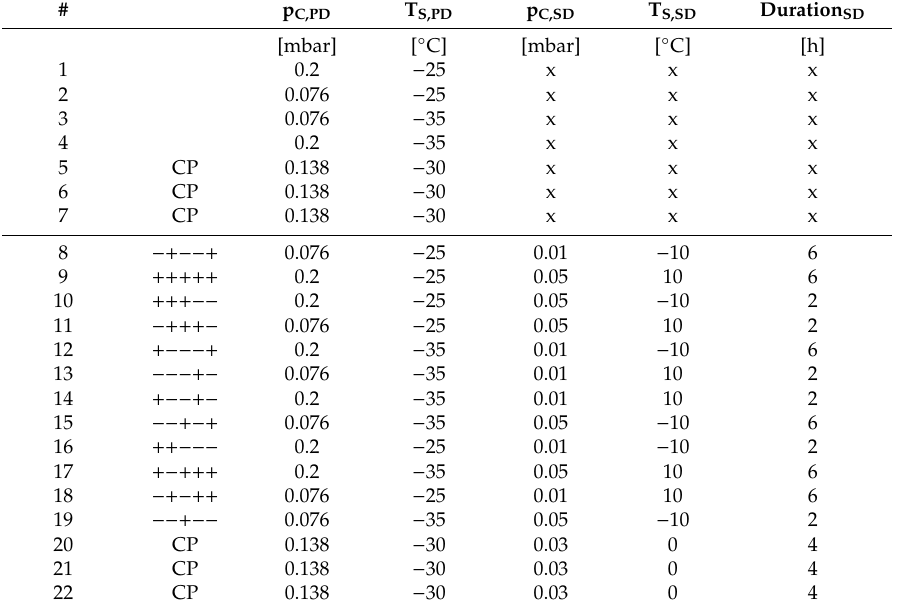
Table 1. Experimental Design of